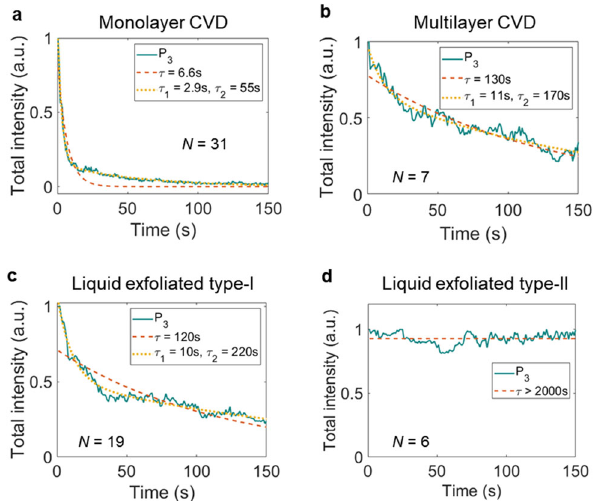
Fig. 2 Total intensity of P3 emission in the air. Since individual time-traces